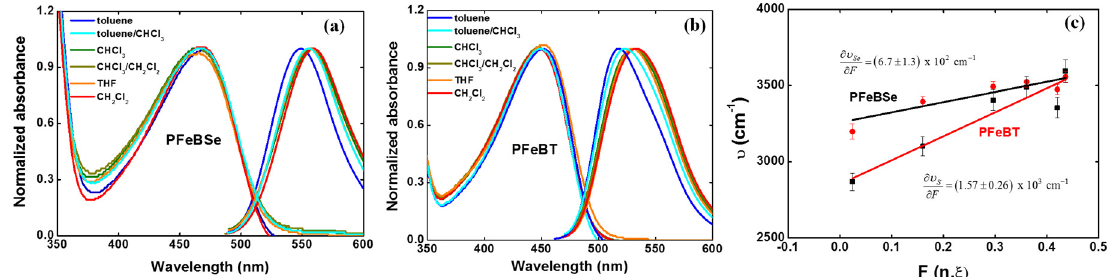
Figure 3. Solvatochromic Stokes shift ( υ ) measurements obtained as a function of the Onsager polarity function ( F ( n , ξ ) ) for ( a ) PFeBSe and ( b ) PFeBT in a series of different solvents (toluene, toluene/chloroform (50%/50%), chloroform, chloroform/dichloromethane (50%/50%), tetrahydrofuran (THF), and dichloromethane). ( c ) Solvatochromic measurements for both polymers illustrating the increase in Stokes shift with the increase in solvent polarity.